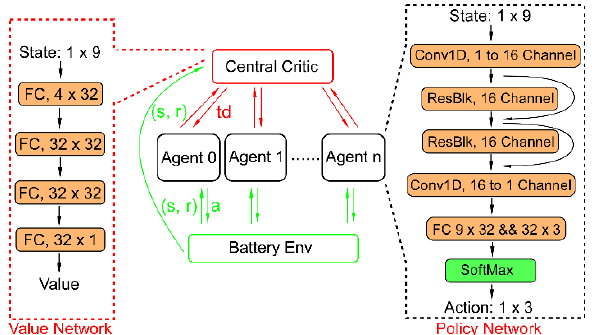
Figure 6. Multi-agent actor-critic training method for battery scheduling. The agent consists of two ResNet layers followed by a fully connected layer, and the central critic consists of three fully connected layers.